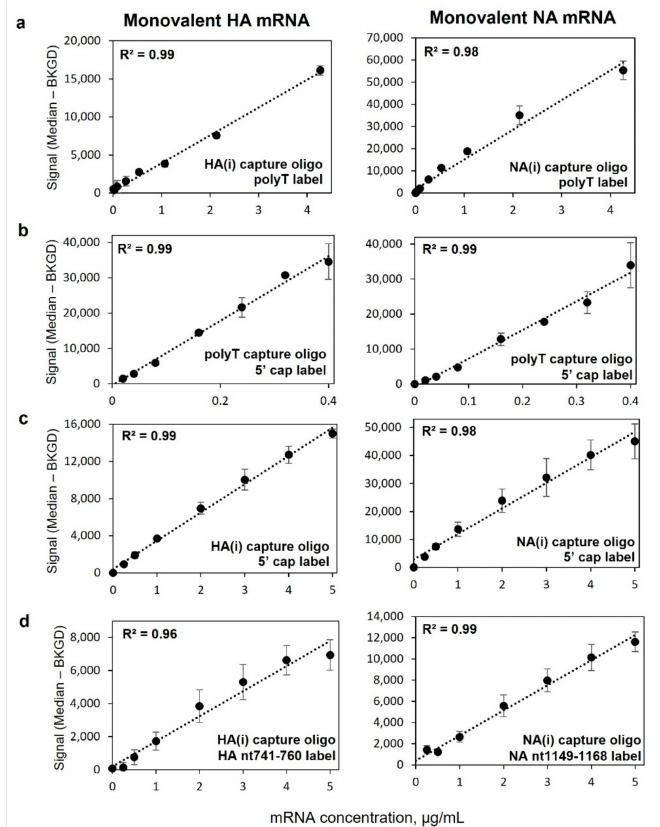
Figure 3. Linearity of response for a variety of capture and detection schemes in monovalent mRNA samples, with HA in left column and NA in right column. ( a ) Coding region capture with polyT label as shown in Figure 1e(i), ( b ) polyT oligo capture with 5 (cid:48) cap antibody label as shown in Figure 1e(iii), ( c ) coding region capture and labeling with 5 (cid:48) cap antibody label as shown in Figure 1e(ii), ( d ) coding region capture with coding region labeling, as shown in Figure 1e(iv). Data points are the average of three replicates and error bars indicate ± 1 standard deviation. R 2 in upper left of each plot is based on a single linear